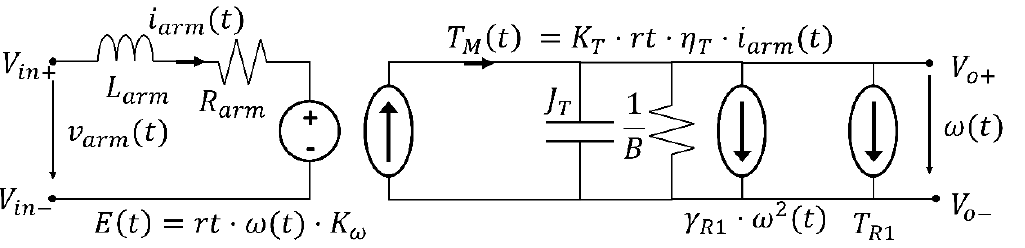
Figure 5. Vehicle and electric motor equivalent circuit.